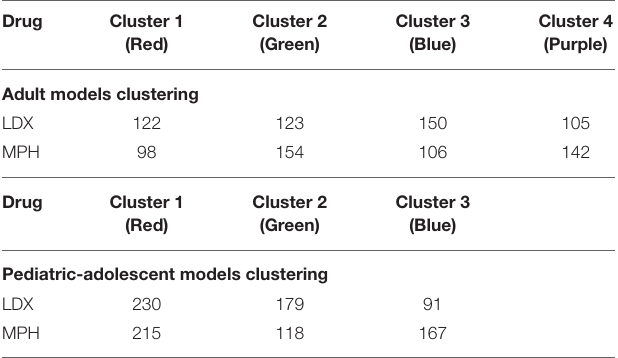
TABLE 6 | Distribution of LDX and MPH mechanistic models in the generated